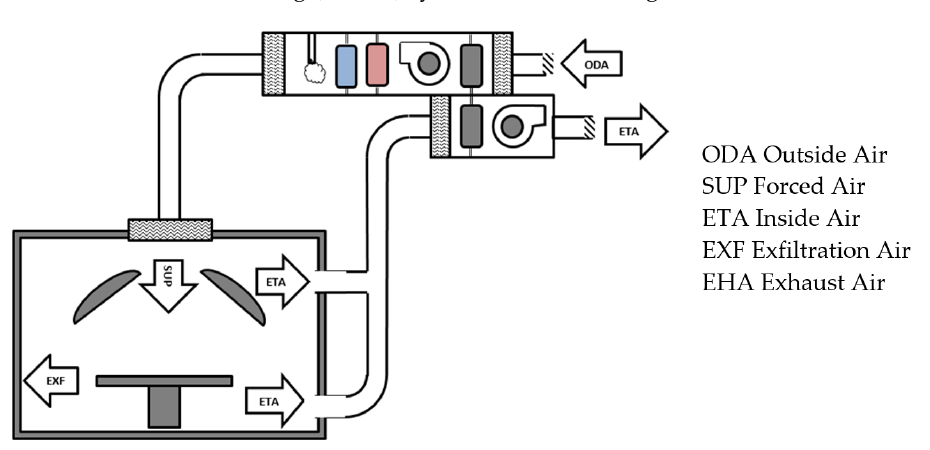
Figure 2. Working Principle of HVAC and AHU in ORs. The HVAC system is regulated from three setpoints that are measured and recorded at the same